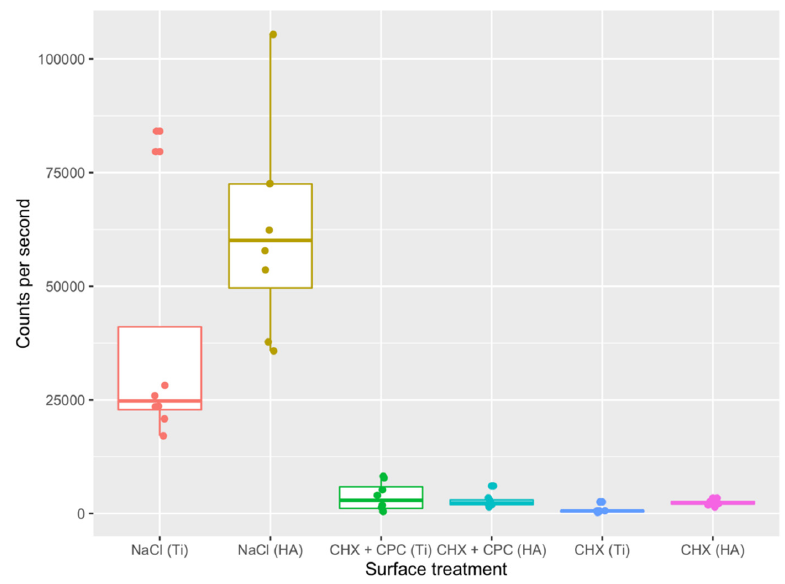
Figure 1. Bacteria viability after 24 h of in situ plaque collection and treatment with NaCl, CHX + CPC or CHX at two types of surfaces (i.e., Ti and HA).